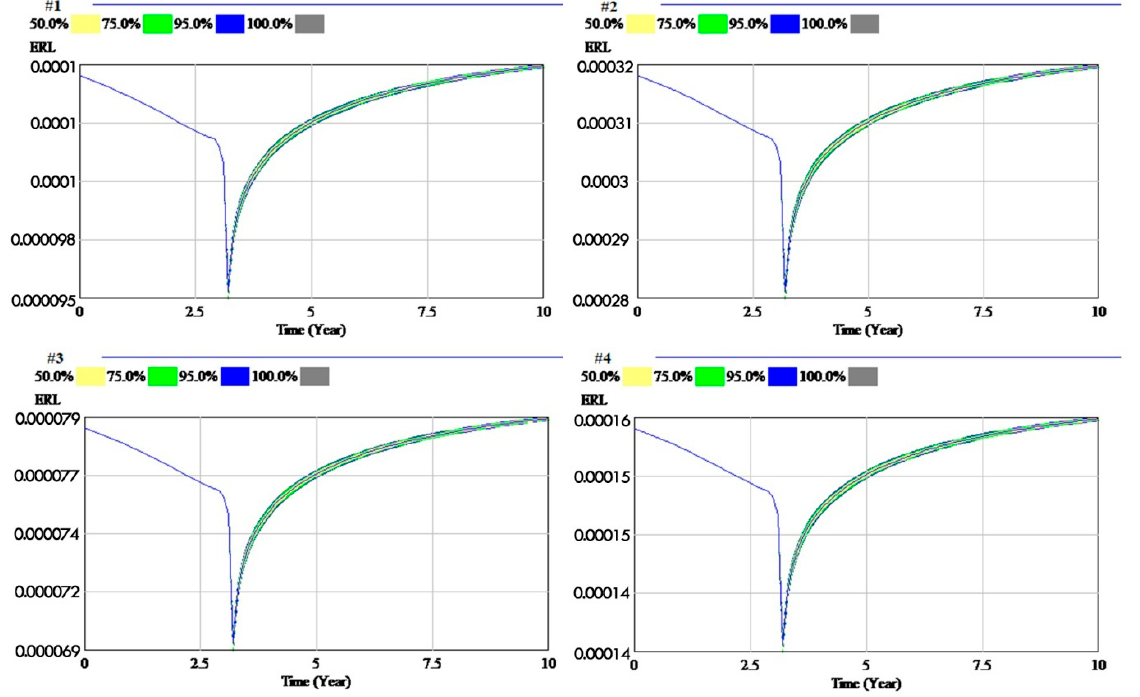
Figure 20. SD sensitivity trace range under multivariate uncertainty—ERL over 10 years for Case #1 to #4.